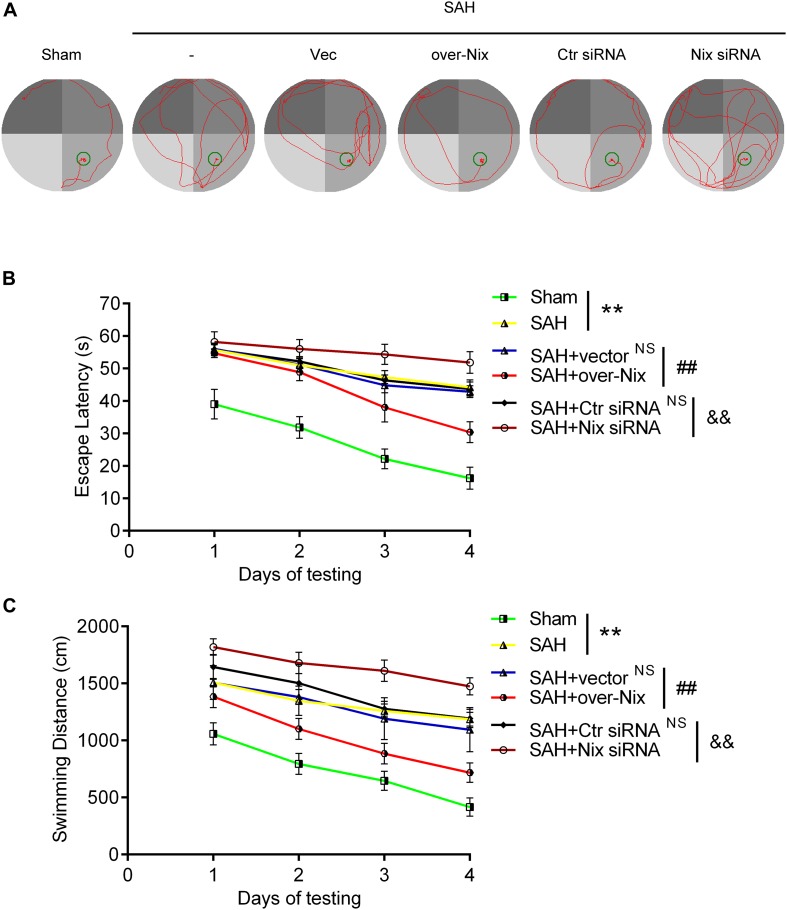
Cognitive behavioral impairment of rats were detected via the Morris water maze. (A) Representative tracing images from the Morris water maze test in the Sham, SAH, SAH + Vec, SAH + over-Nix, SAH + Ctr siRNA, and SAH + Nix siRNA groups. (B,C) Escape latencies and swimming distance over 4 days. Data represent the mean ± SD; **p < 0.01 vs. Sham group; NSp > 0.05 vs. SAH group; ##p < 0.01 vs. SAH + Vec group; &&p < 0.01 vs. SAH + Ctr siRNA group; n = 6.